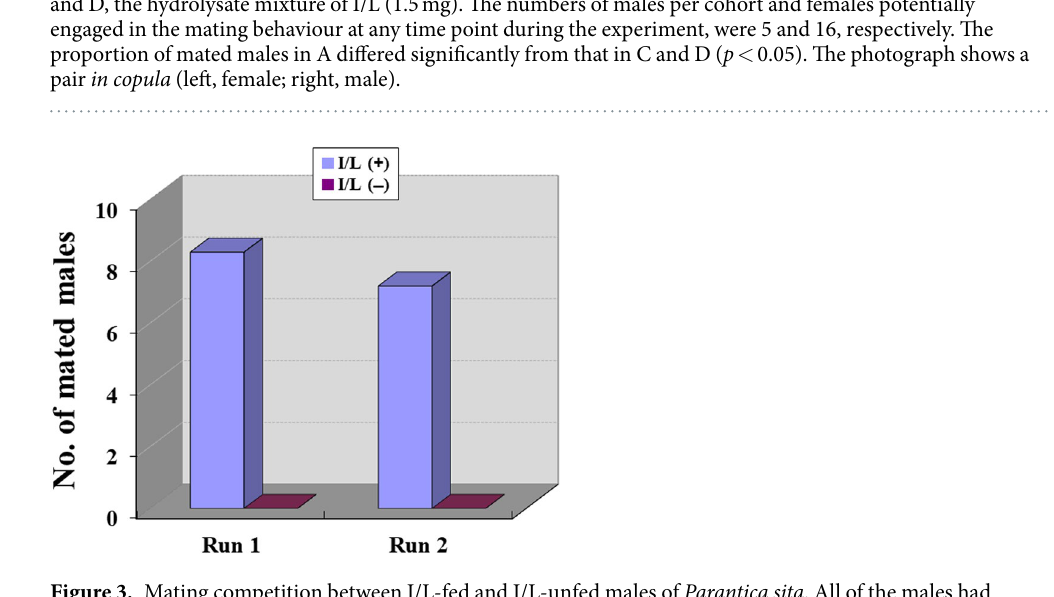
while that in the I/L( − ) cohort was 65.4% (17 of 26). As in the preceding experiment (Supplementary Table S1), the amount of DO found in the hairpencils of the mated males was very small after copulation. Effect of I/L ingestion on the courtship activity of males without the sex pheromone. Only two individuals of I/L-fed males achieved copulation, while none of the control (I/L-unfed) males did. Apparently, sig- nificantly larger number of I/L-fed males courted females when compared with control males (U = 41.5, z = 3.11, p = 0.0019) (Fig. 5a). At the same time, no significant difference in the sum total of males that performed flight activities (including pursuit of a female, foraging, or patrolling) was found between I/L-fed and control males (U = 101.5, z = 0.43, p = 0.6587) (Fig. 5b). Overall, the proportion of males that courted females at least once during the whole experimental period (Fig. 5c) was significantly higher in I/L-fed males (82.4%) than in control males (35.7%) ( p = 0.01193), whereas as for the males that engaged in flight activities, the proportion of I/L-fed males (94.1%) did not differ significantly from that of control males (85.7%) ( p = 0.5764). The level of biogenic amines in PA-fed and PA-unfed males.